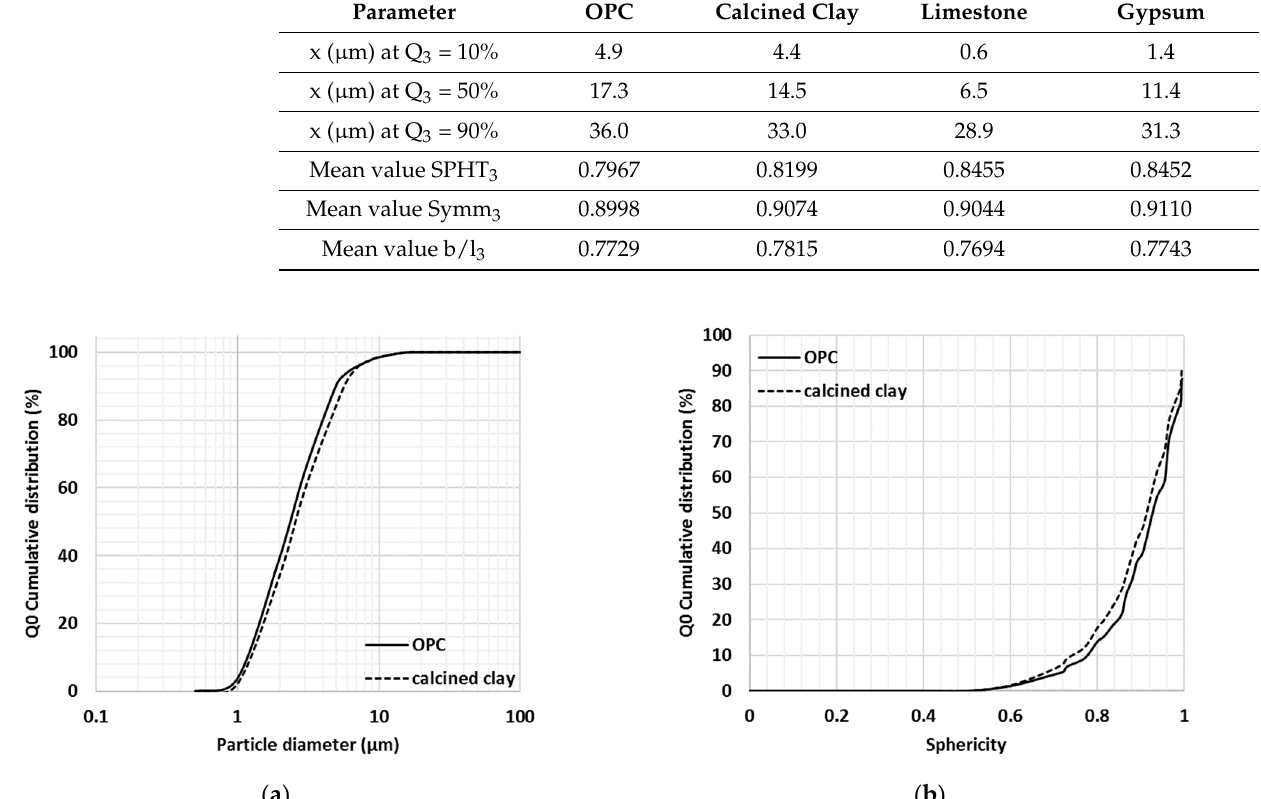
Figure 4. Particle size ( a ) and sphericity ( b ) of calcined clay and cement particles (re-plotted from Fehervari et al., 2019 [40]).